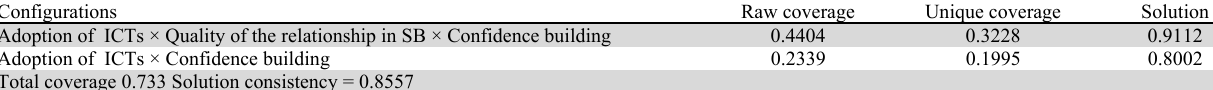
Configurations leading to communication enhancement